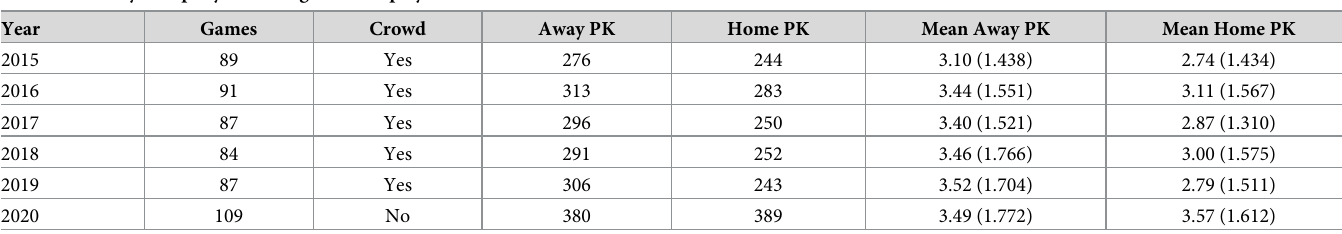
Table 1. Penalty kills per year during the NHL